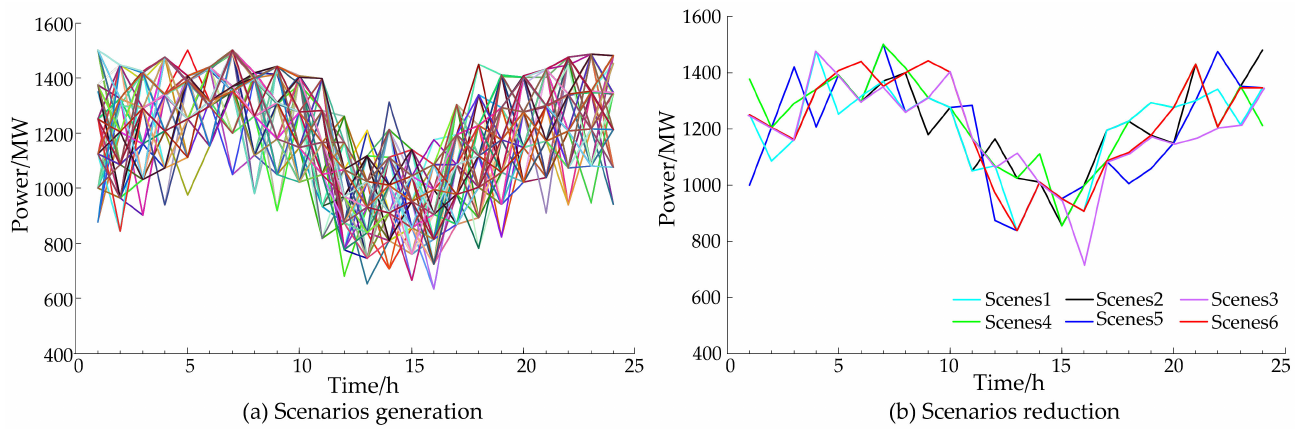
Figure 4. Scenarios reduction for wind power